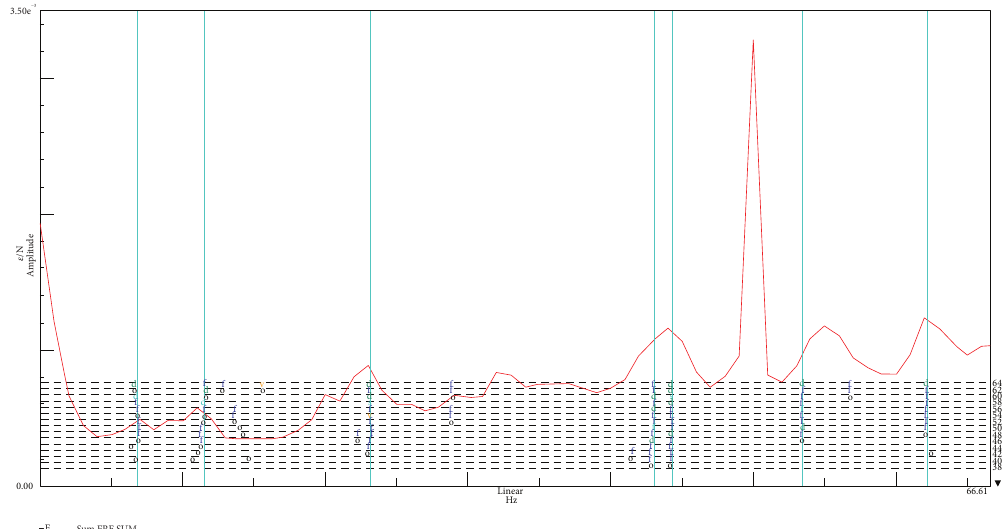
Figure 19: The POLYMAX steady-state diagram of the